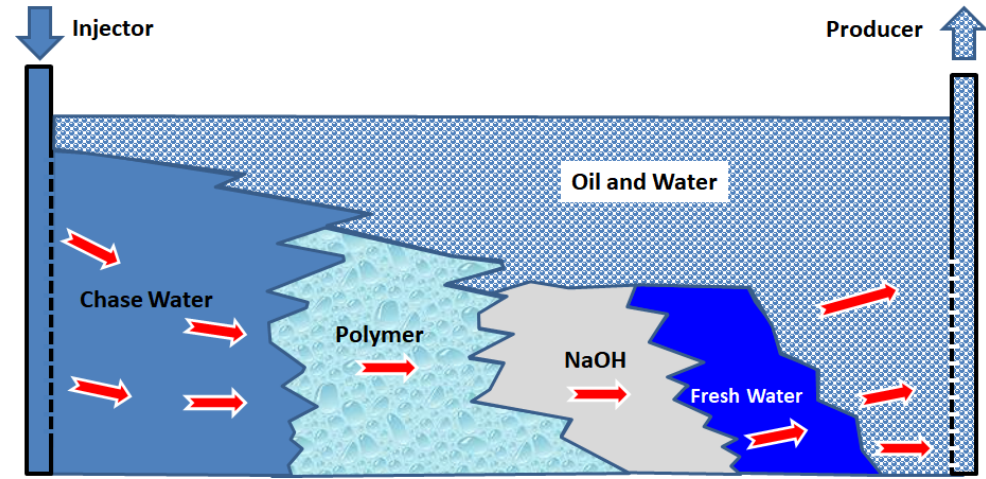
Figure 1. Alkaline flood injection mechanism.